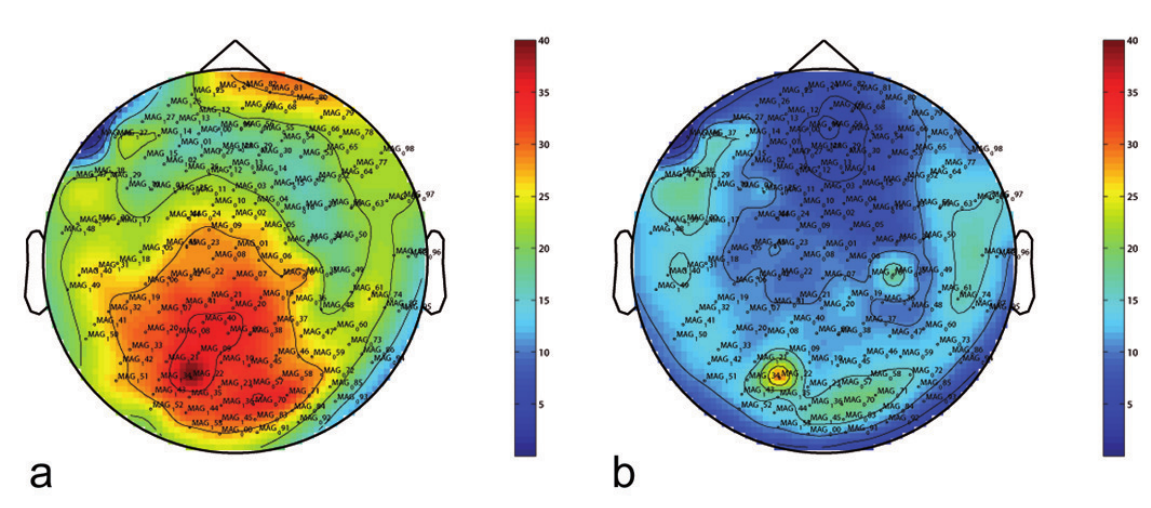
Figure 8. Topographic distribution over the head of the power-spectrum in the range 10–12 Hz before ( a ) and after ( b ) the application of the noise-reduction algorithm (for a subject recorded in resting state with open